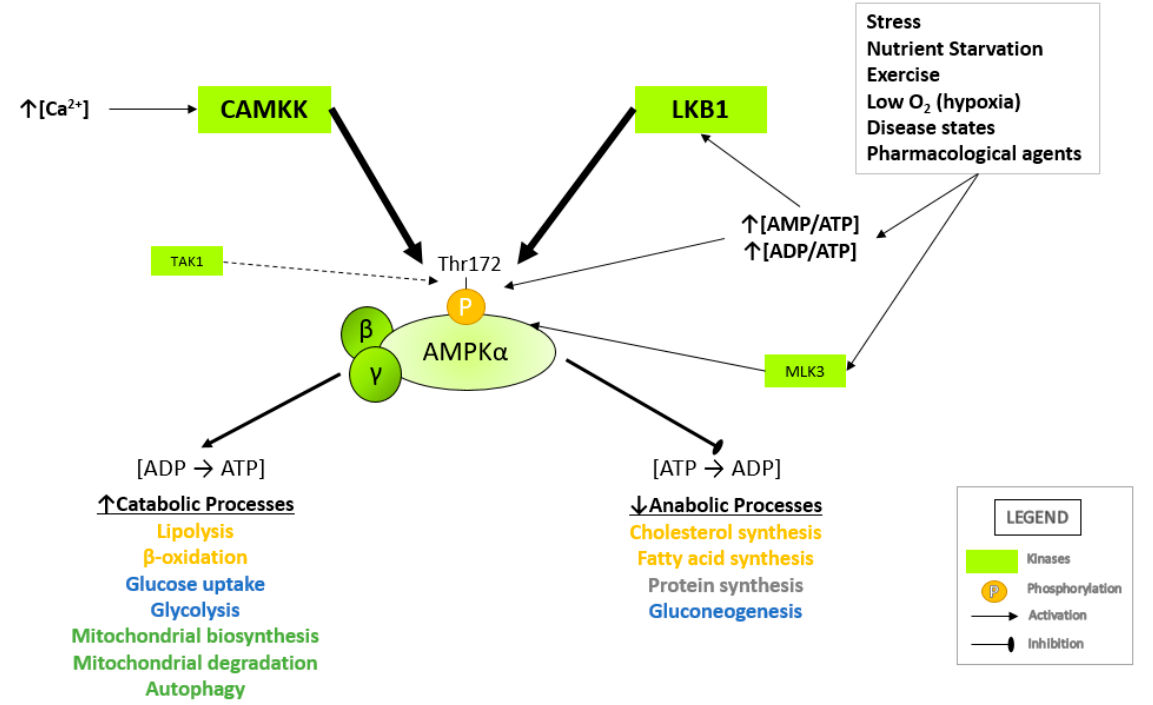
Figure 2. Activation of AMPK by upstream kinases. AMPK is activated following the phosphorylation of Thr172 on the catalytic α -subunit by upstream kinases in response to shifting adenosine nucleotide levels, cytosolic calcium levels and external stressors. Following activation, AMPK regulates anabolic, ATP-consuming pathways and catabolic, ATP-generating pathways. A summary of the physiological roles of AMPK is listed above (arrow indicates activation/increase; bar indicates inhibition/decrease). LKB1, liver kinase B1; CAMKK2, calcium/calmodulin-dependent kinase kinase 2; TAK1, transforming growth factor- β -activated kinase 1; MLK3, mixed lineage kinase 3.